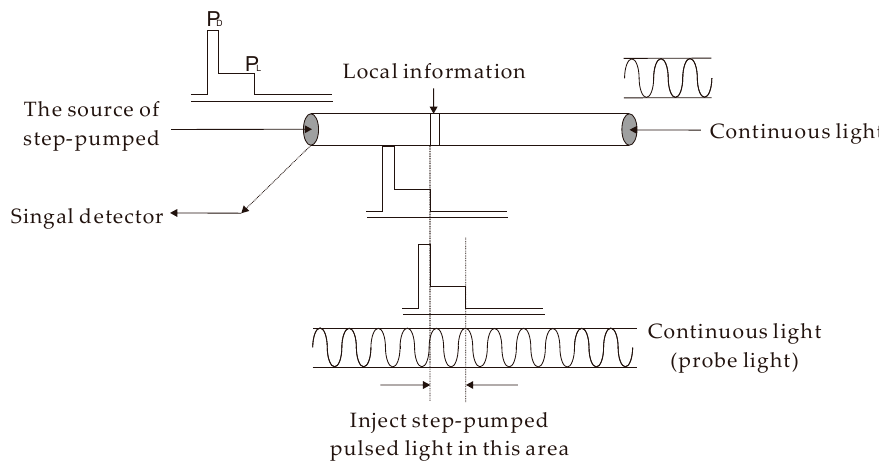
Figure 2. Monitoring schematic diagram of Brillouin optical time-domain analysis (BOTDA).